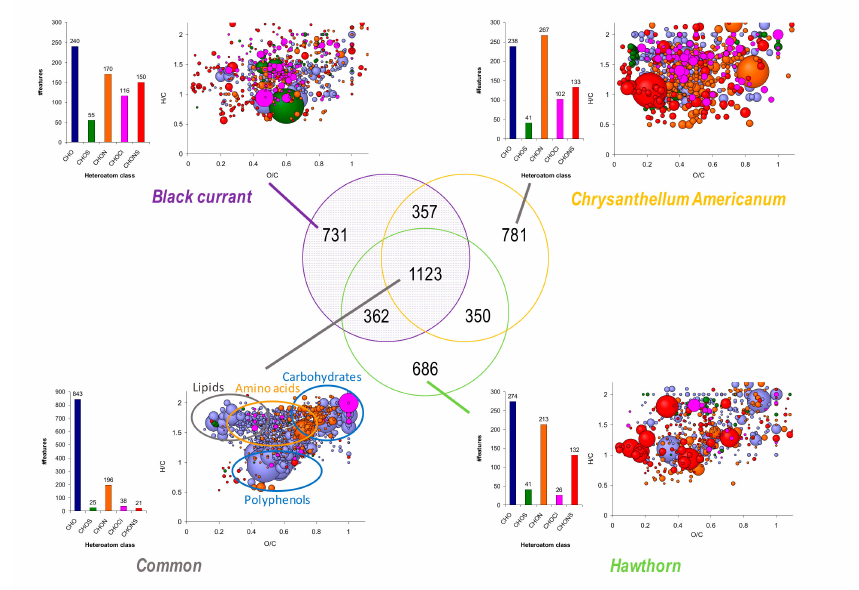
Figure 6. Venn diagram achieved from BC, CA, and HAW samples analyzed in ESI(-) FT-ICR MS. Heteroatom class distribution and van Krevelen diagram concern features specifically and commonly observed in all samples. Lot numbers: see Figure